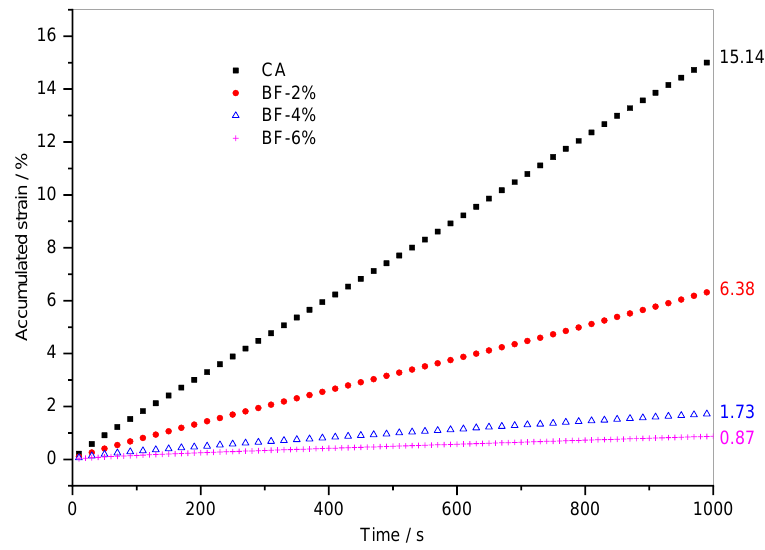
Figure 7. Evolution of accumulated strain versus time for composites with brucite fiber.